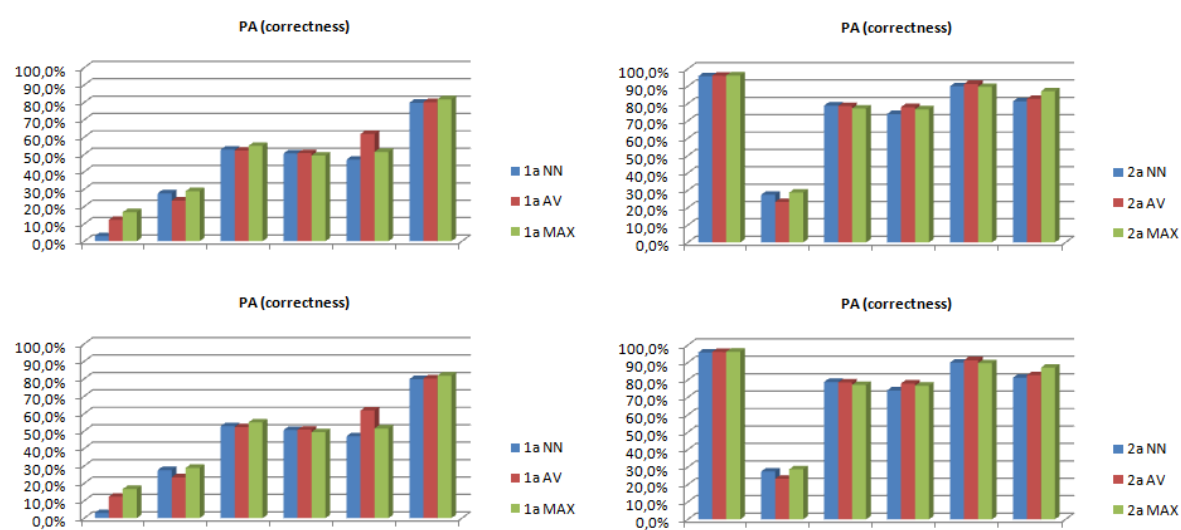
Figure 6. Producer’s and User’s accuracy of land cover/use classification for the different interpolation methods of multispectral ALS intensity rasters, in approaches using spectral classification (variants of Approach 1) supported by the nDSM (variants of